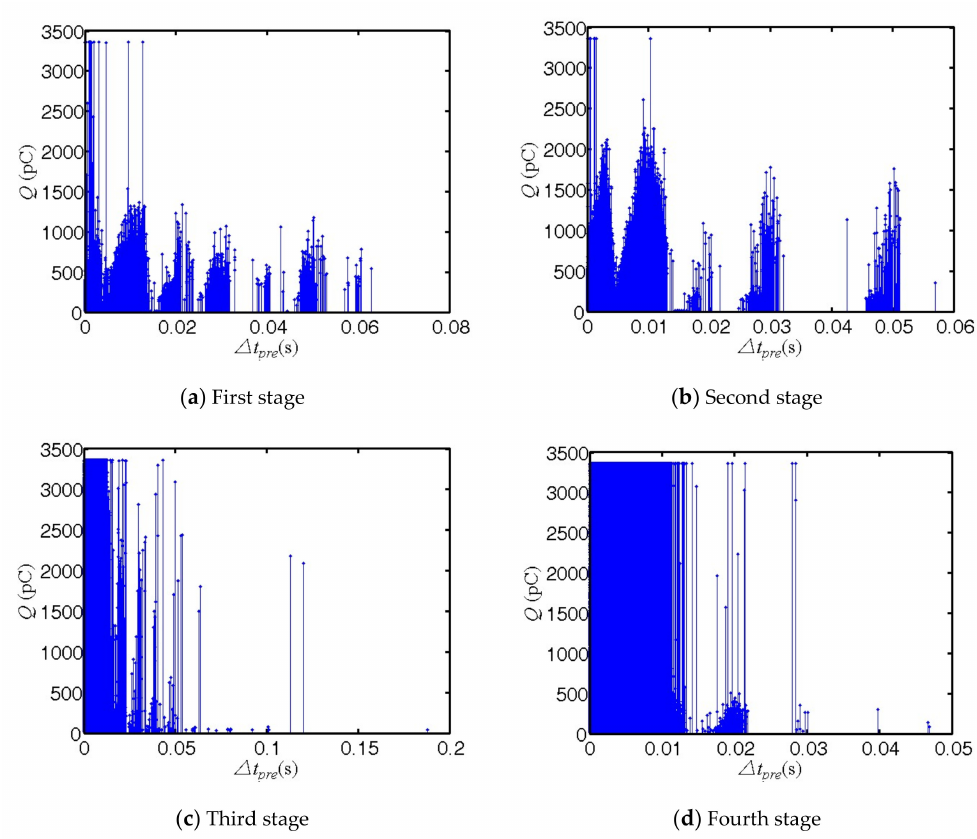
Figure 5. ∆ t pre - Q two-dimensional characteristic spectra after dimensionality reduction correspond- ing to each stage of Figure